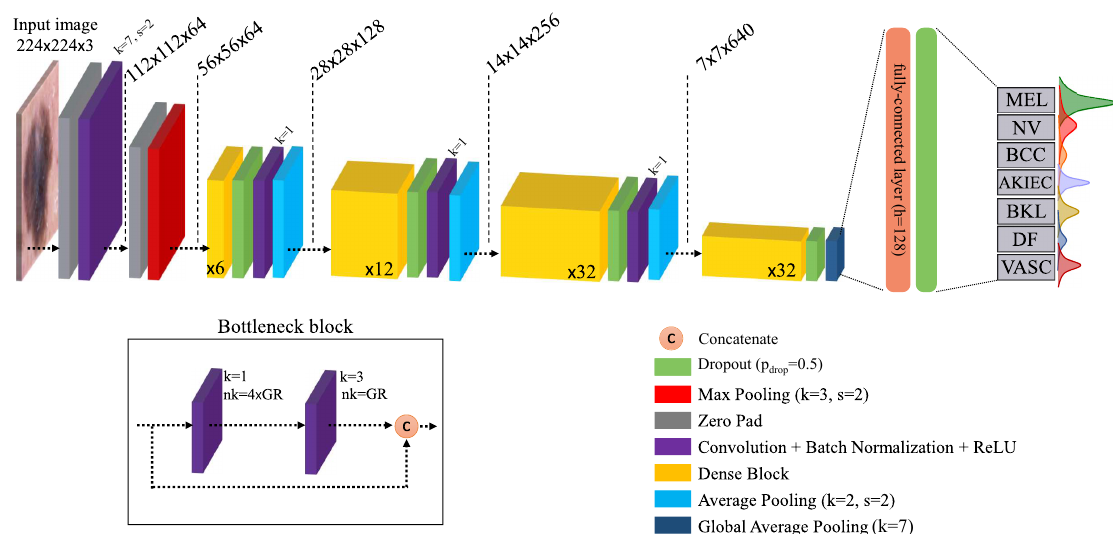
Figure 2. Schematic of the Bayesian DenseNet-169 architecture. The diagram shows the entire pipeline for the system which is trained end-to-end. Instead of a single scalar, Bayesian network outputs a predictive distribution per class whose mean and dispersion represents the network prediction and uncertainty, respectively. The number in the dense blocks corresponds to the number of bottleneck block within that dense block. k : kernel size, s : stride, nk : number of convolutional kernels, GR : growth rate [59].